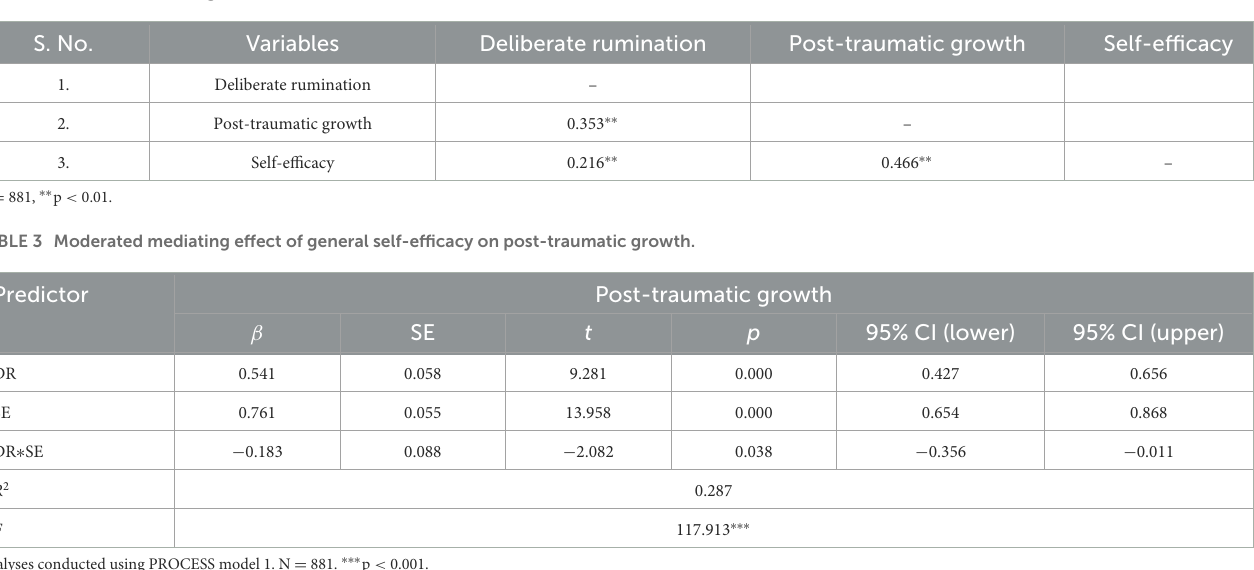
TABLE 2 Correlations among variables.